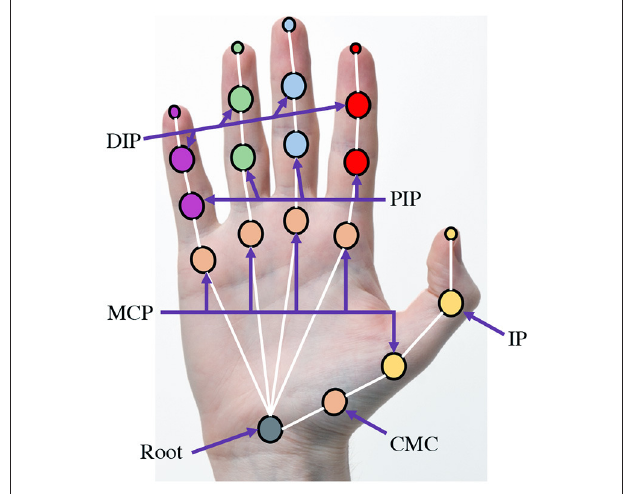
FIGURE 2 | Structure of the human hand. The various joint names are: Metacarpophalangeal (MCP) joint, Distal interphalangeal (DIP) joint, Proximal interphalangeal (PIP) joint, and Carpometacarpal (CMC)